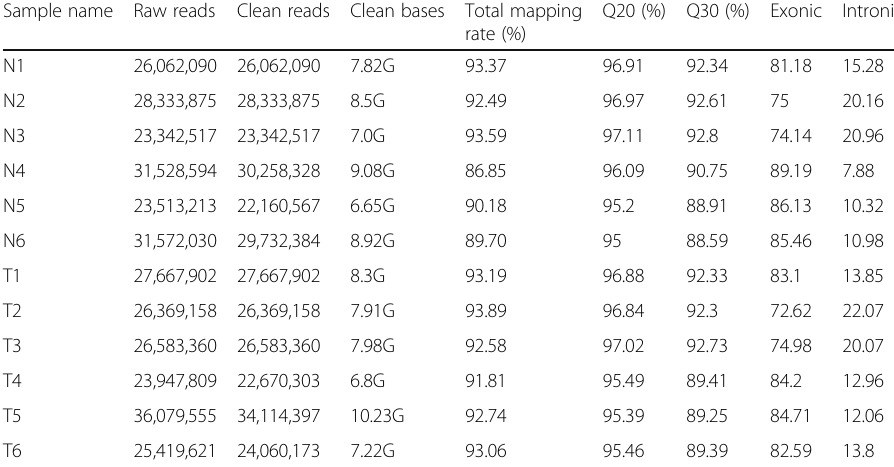
Table 1 The details of the transcriptome assembly result Sample name Raw reads Clean reads Clean bases Total mapping